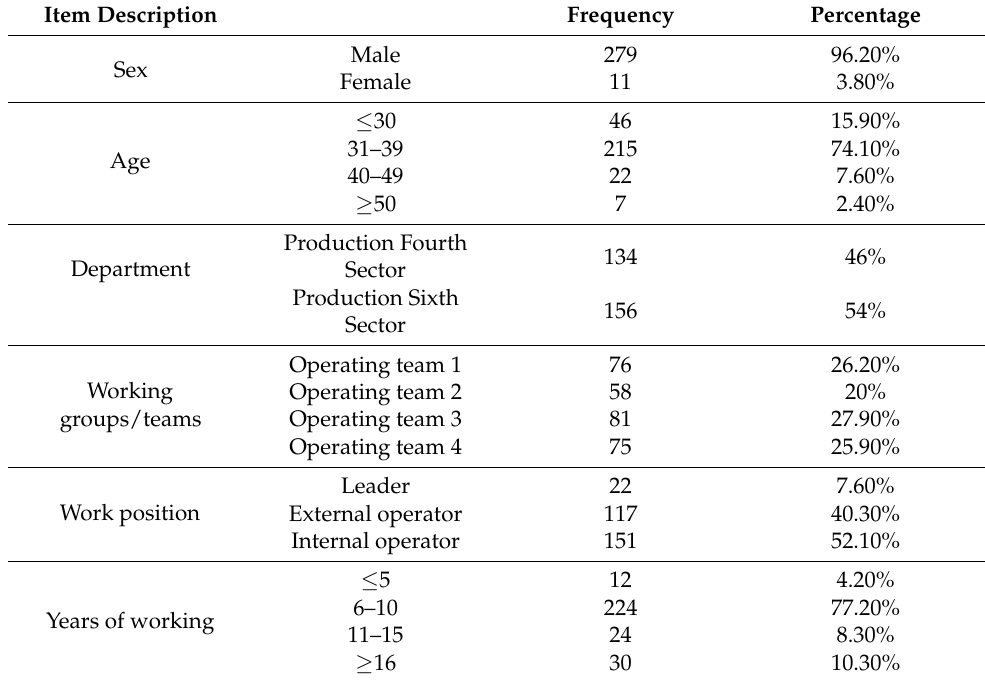
Table 1. Descriptive statistics of